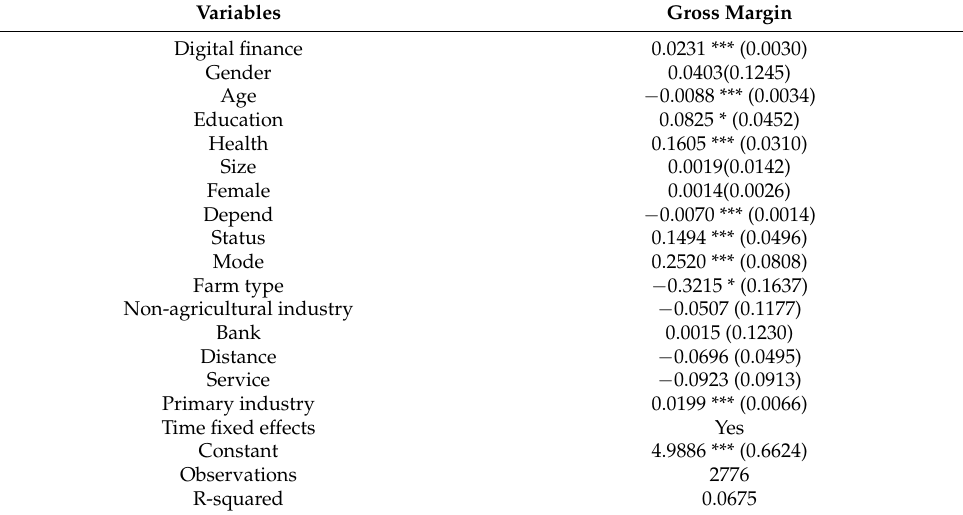
Table 2. Estimated results of digital finance index on the agricultural income.